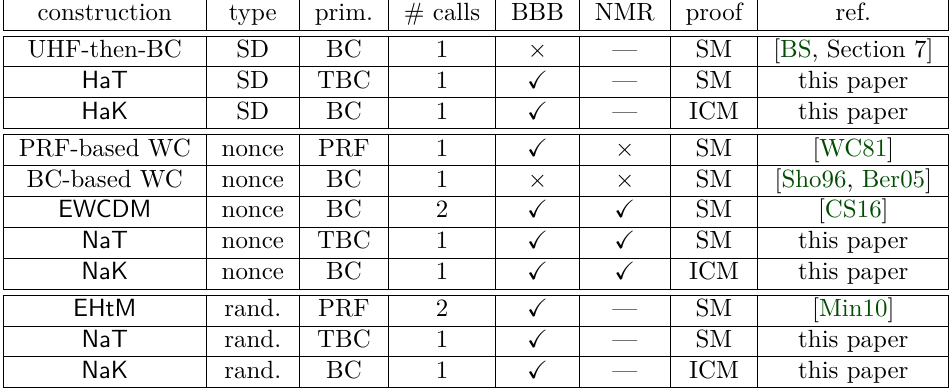
Table 1: Comparison of our new constructions with prominent existing MAC constructions based on an arbitrary (xor-)universal hash function. WC stands for Wegman-Carter; SD stands for stateless deterministic; “prim.” indicates which primitive is used in addition to the UHF; “# calls” gives the number of calls to the underlying primitive (in addition to the UHF call); “BBB” indicates whether the construction is secure beyond the birthday bound (when nonces are not repeated for nonce-based ones); “NMR” indicates whether nonce- based constructions are nonce-misuse resistant; “proof” indicates whether the security proof is in the standard model (SM) or the ideal cipher model